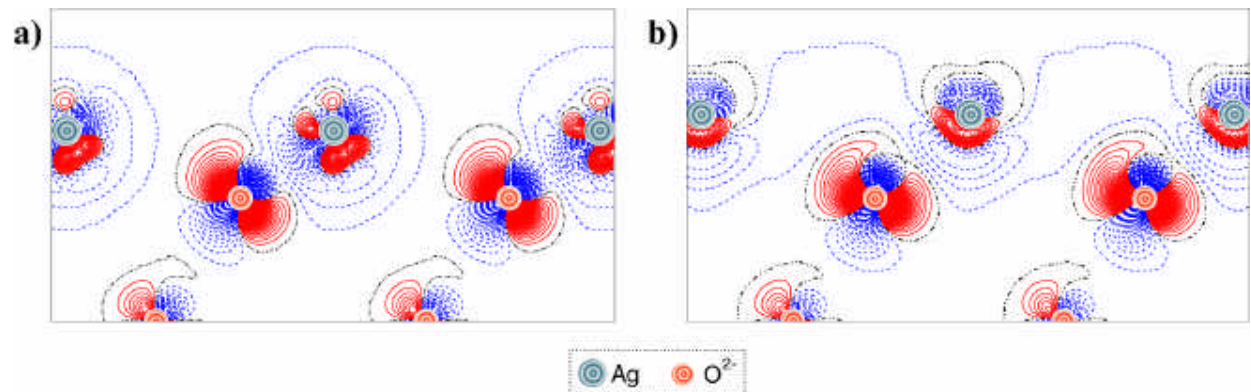
Figure 5 . The pair of electron density plots similar to those shown in Fig. 4, but for O-terminated sub- strate (Figs. 2a and 3): 1/3 Ag ML (a) and 1 Ag ML (b). Note that the isodensity curves are